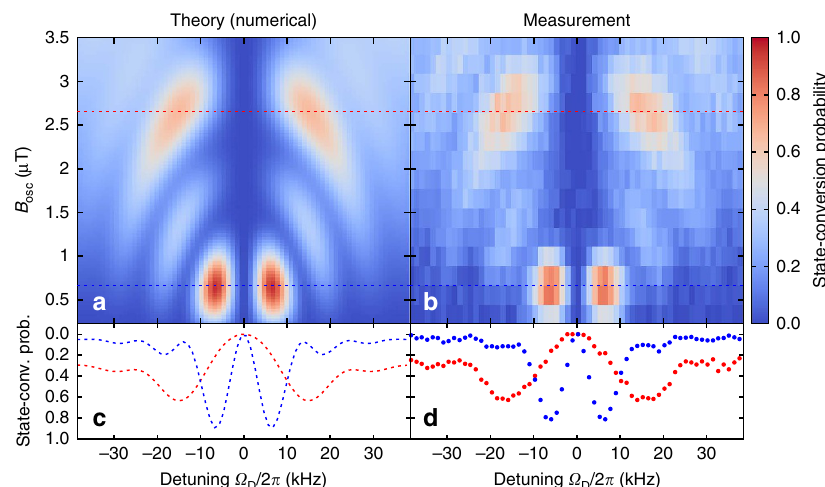
Figure 5 | State-conversion maps with a velocity spread. Comparison of theoretical and measured state-conversion probabilities as a function of the detuning O D /2 p in units of kHz and the amplitude of the oscillating magnetic field B osc in units of m T. The theoretical map ( a ) includes the effect of a Gaussian-like velocity distribution with (cid:2) V H ¼ 1,060ms (cid:3) 1 and s V ¼ 95ms (cid:3) 1 . The measurement ( b ) was taken setting a large distance between the permanent sextupole magnets of d s ¼ 115mm, as it has been used for the sets 1 and 10. The blue and red dashed horizontal lines indicate the driving strengths, where the first and second full-state conversion would be reached in the case of a monoenergetic beam. The plots ( c , d ) are projections of the state-conversion probabilities at the dashed lines showing good agreement between theory and measurement. Frequency spectra across the narrow double-dips at the first state conversion yield the highest precision.